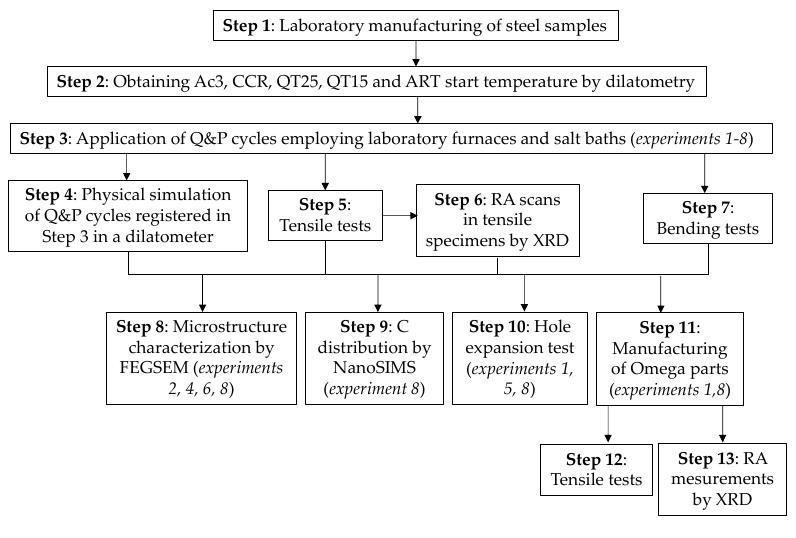
Figure 3. Experimental flow chart.